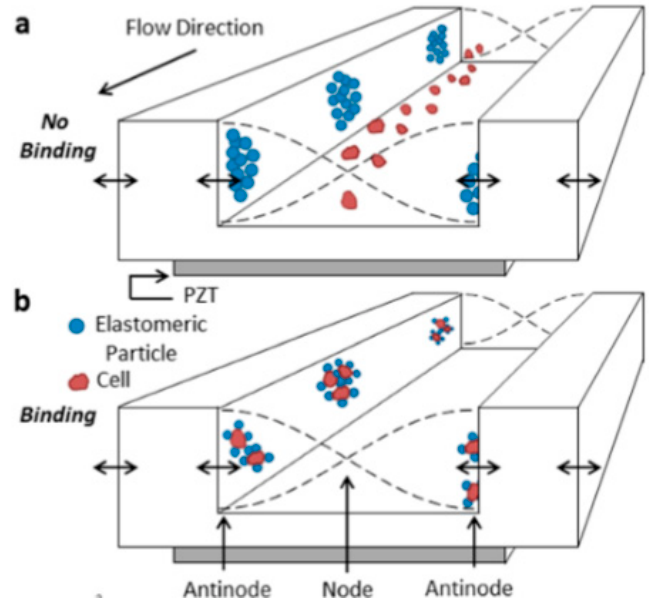
Figure 5. Distribution of: ( a ) elastomeric particles and cells and ( b ) cells binded with elastomeric particles in nodes and antinodes of the acoustic standing wave. Reprinted with permission from [166]. Copyright 2014, American Chemical Society.